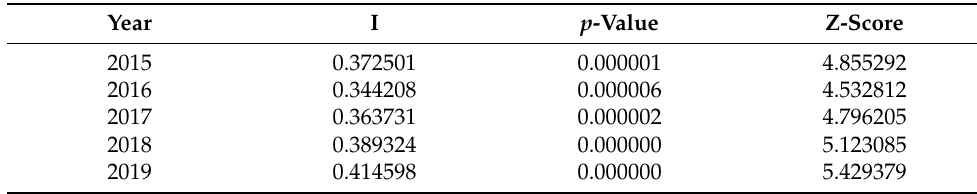
Table 2. Global Moran’s I from 2015 to